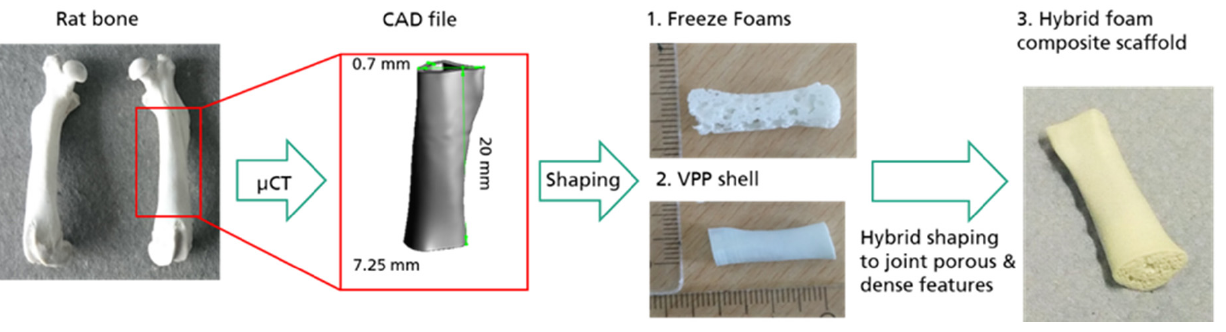
Figure 4. CT images of an exemplary hybrid structure; from left to right: left: VPP support structure (green state); middle: hybrid (green state); right: sintered hybrid ( A : plan view, B : side view). SEM images clearly showed the denser VPP-manufactured round column and the porous Freeze Foam (Figure 5). At the junction between them, several gaps appear. Foam and the VPP part fused together, but only partially and only in a few spots. However, this SEM analysis only shows one specific location within one hybrid structure. More hybrids need to be manufactured and examined to come to a general conclusion. Figure 5. FESEM cross-cutting images displaying interface between VPP-manufactured column and Freeze Foam; magni- fication/HFW 35×/3334 μ m ( left ); 100×/1160 μ m ( middle ); 500×/242 μ m ( right ); 8 kV acceleration voltage. The gap between column and foam was measured at one location (Figure 6), which varied between 1 and 13 μ m. In general, the column was much denser than the foam, with macropores of around 100 to <600 μ m. A closer look at a higher magnification showed mesopores of around 1–2 μ m in the foam and in the struts (Figures 5 and 6).